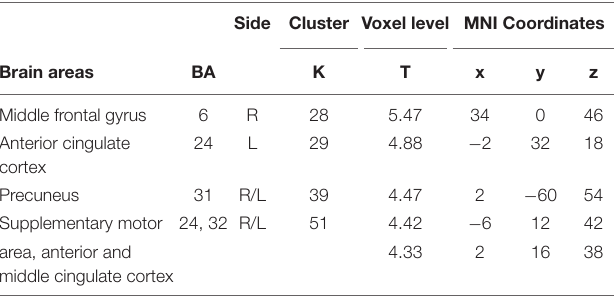
Side Cluster Voxel level MNI